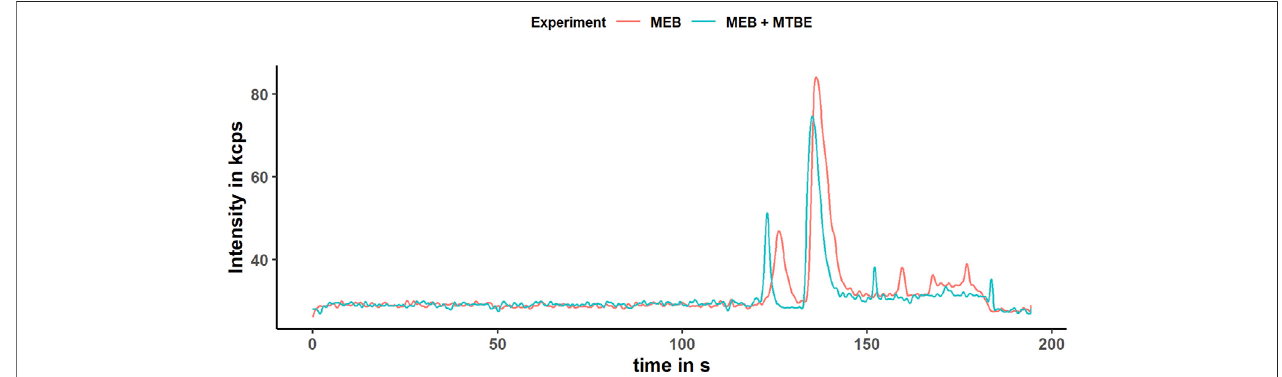
FIGURE 5| Electropherogram of the extracts obtained according tothe modi fi ed protocol with (blue) and without (red) organic solvent.The electropherogram was obtained after smoothing the data by applying the Savitzky – Golay fi lter. The determined isotope was Fe-56 in the DRC-ammonia mode.